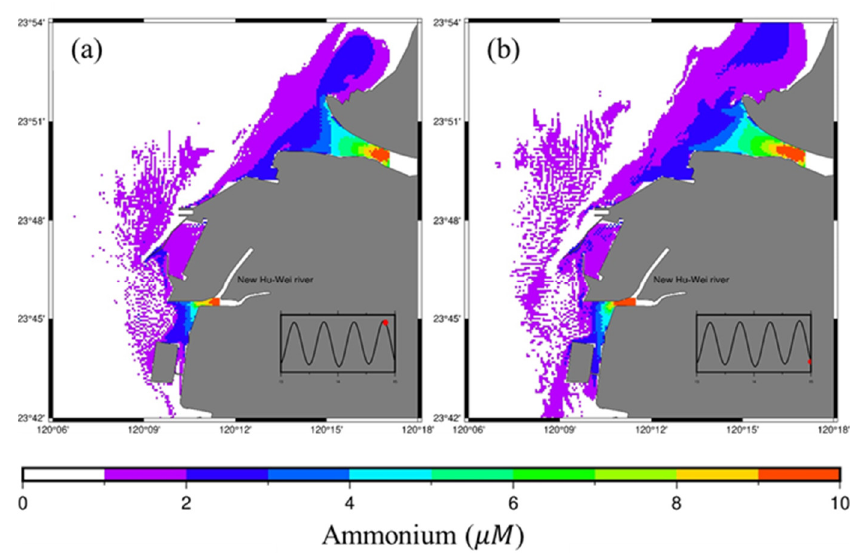
Figure 14. The ammonium-concentration fields of the instantaneously model output during the ( a ) high slack water and ( b ) low slack water. A small insert at the lower-right corner indicates the tidal phase.